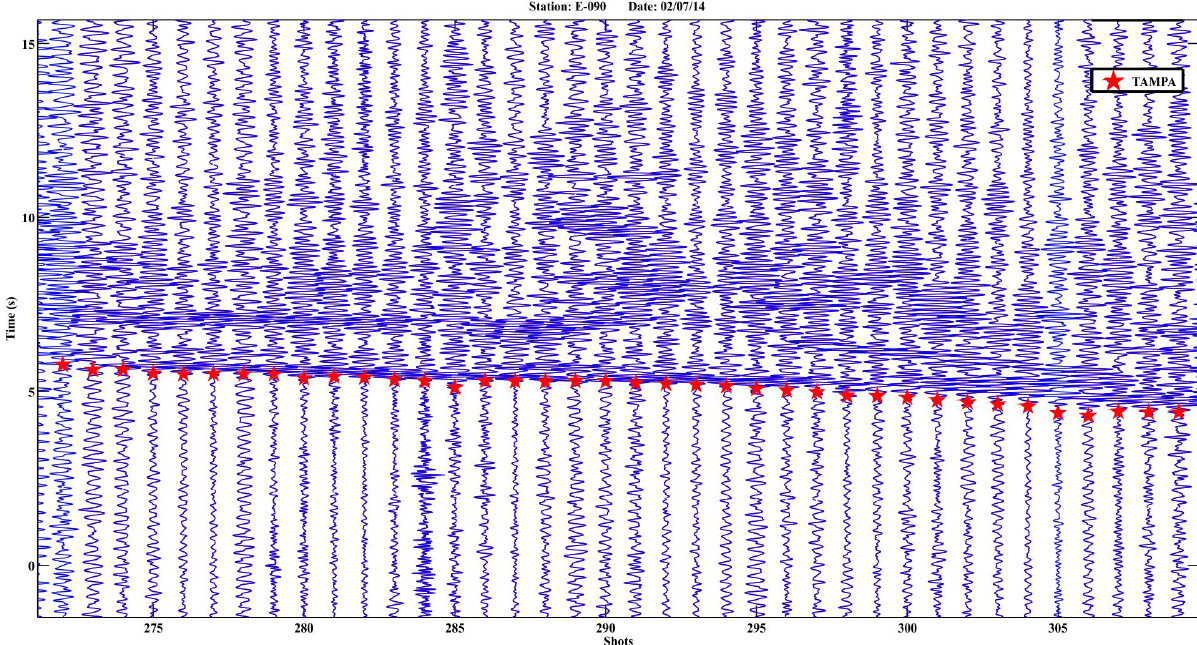
Figure 21. An example of different correlative shots recorded in a single short-period portable station. (Date format: